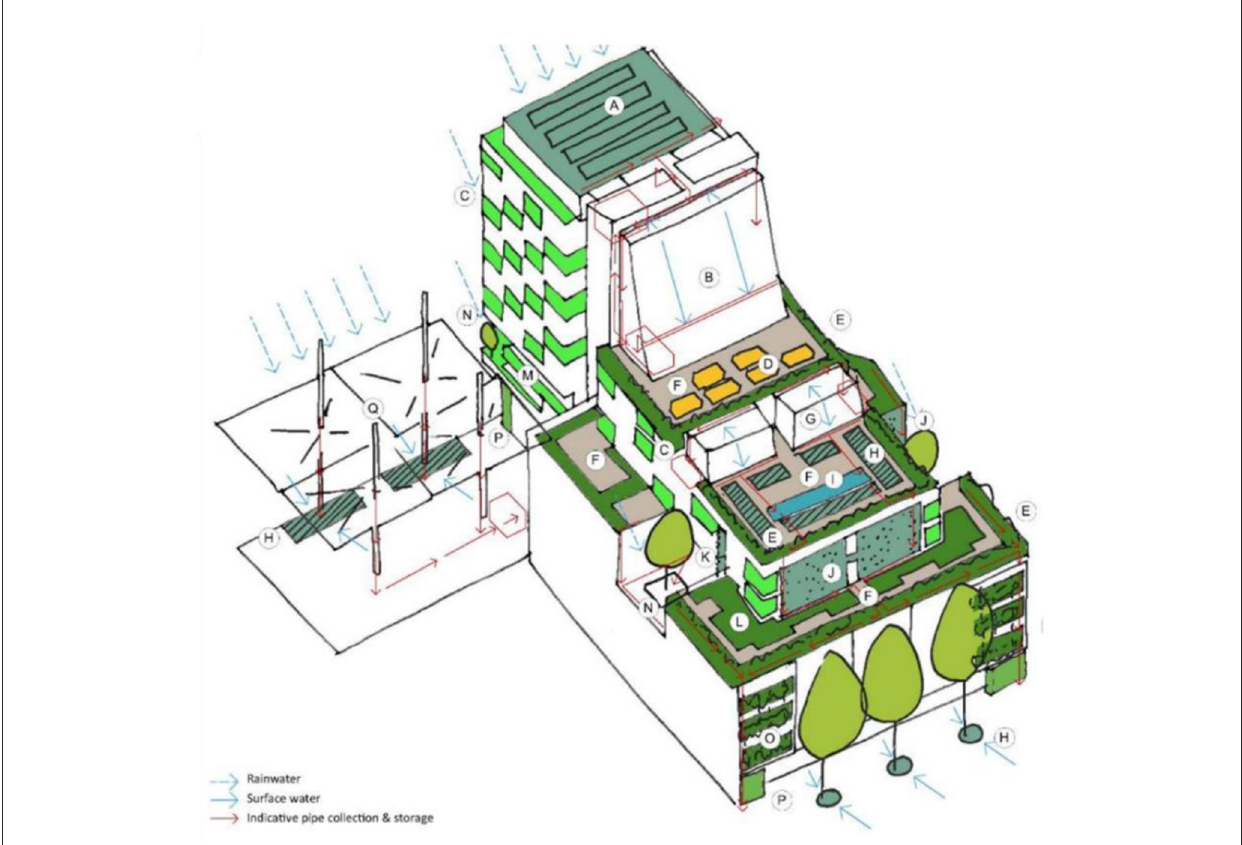
FIGURE5 Sustainable drainage strategy. Diagram presented to focus group participants with verbal explanation of broader proposed water management for the building. Image reproduced with kind permission from the architects.